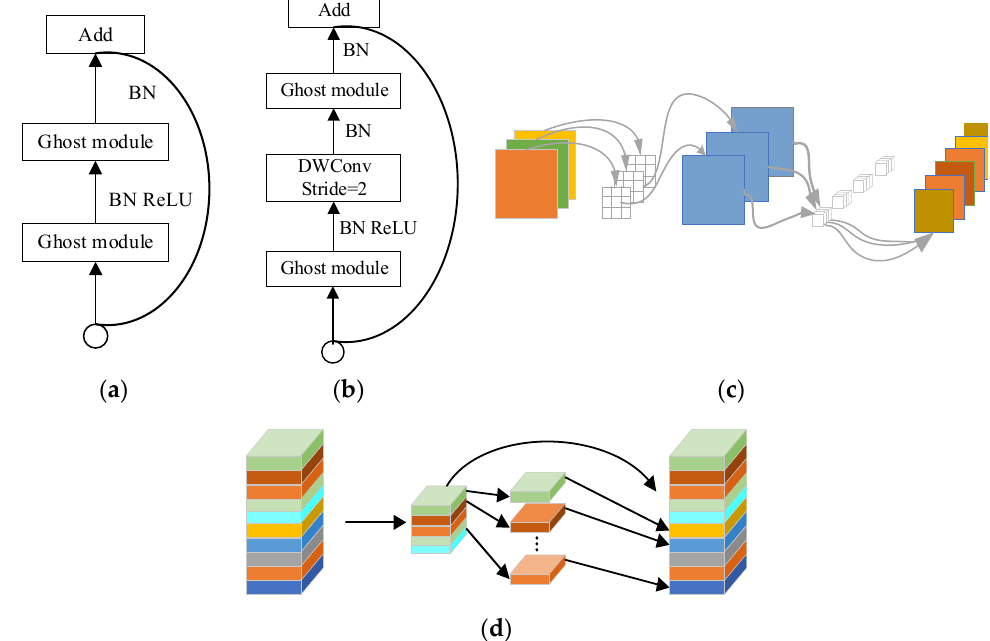
Figure 4. Structure diagram of Ghost Bottlenecks. ( a ) stride = 1 Bottleneck, ( b ) stride = 2 Bottlenecks, ( c ) DWConv, ( d ) Ghost module.